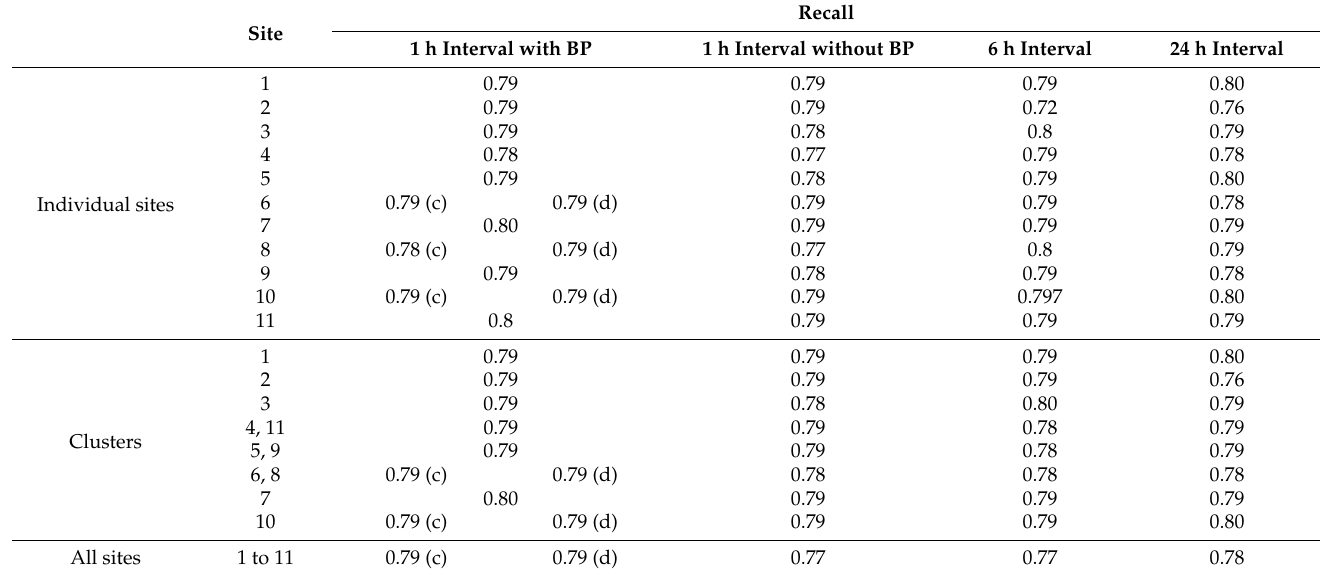
Table 9. Recall in tendency classification.